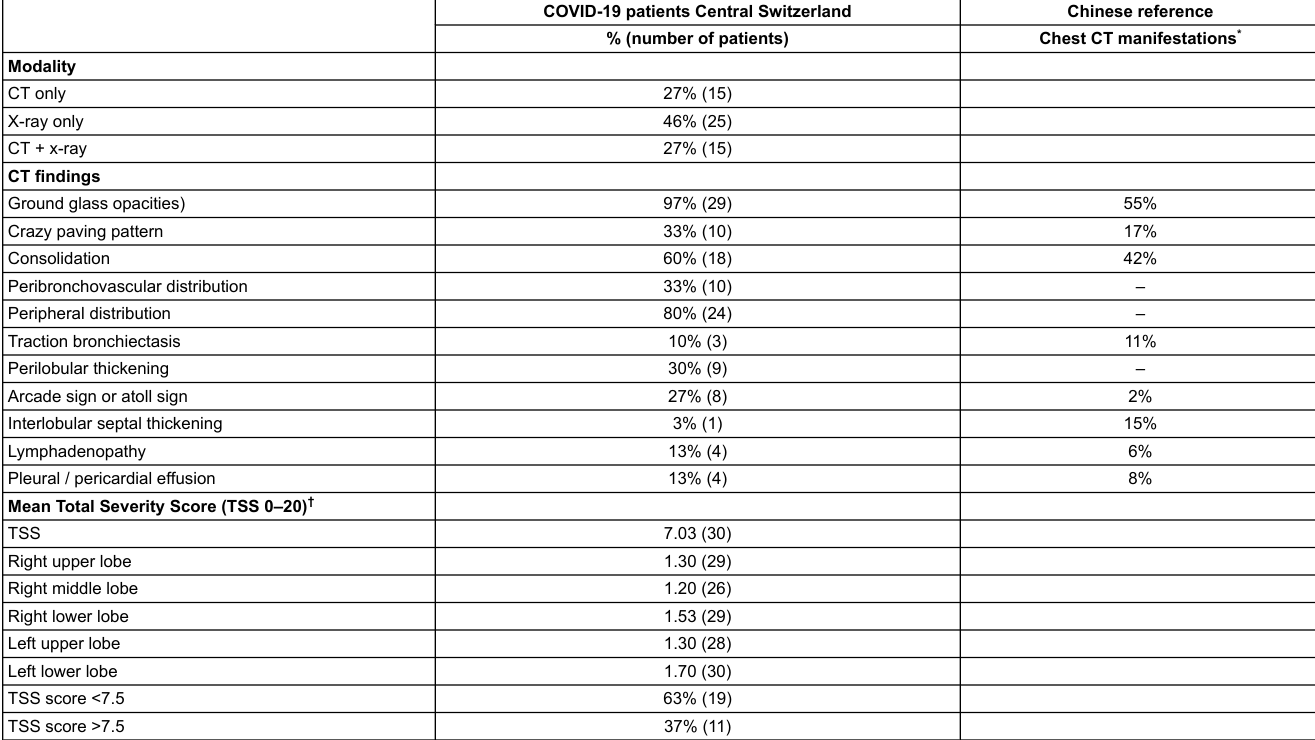
Table 2: Chest computed tomography (CT) imaging findings in our COVID-19 patient cohort compared with Chinese experience (n =